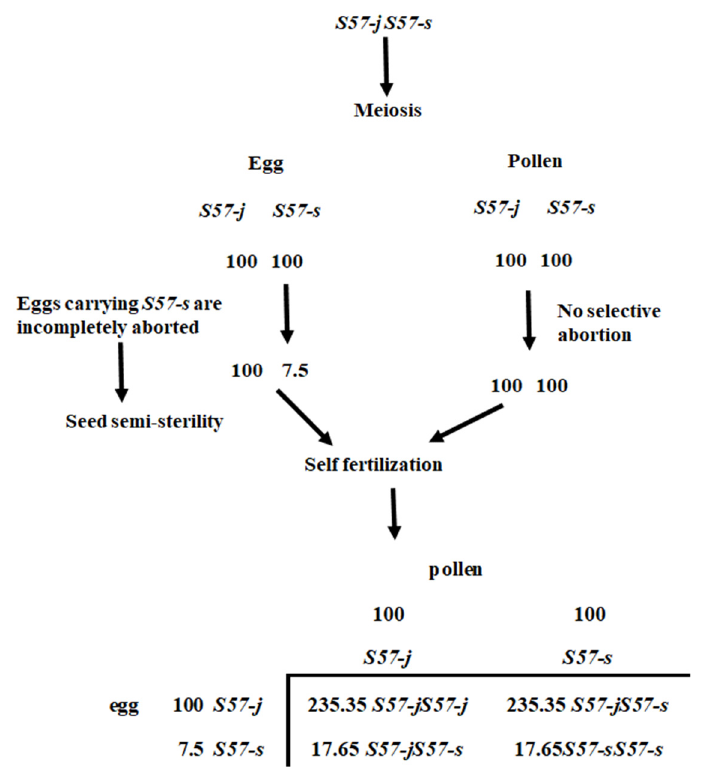
Figure 5. Genetic model explaining the seed semi-sterility and segregation distortion in the geno- type of S57-j S57-s at S57 locus. The transmission ratio of S57-s is inferred from observed data in Table